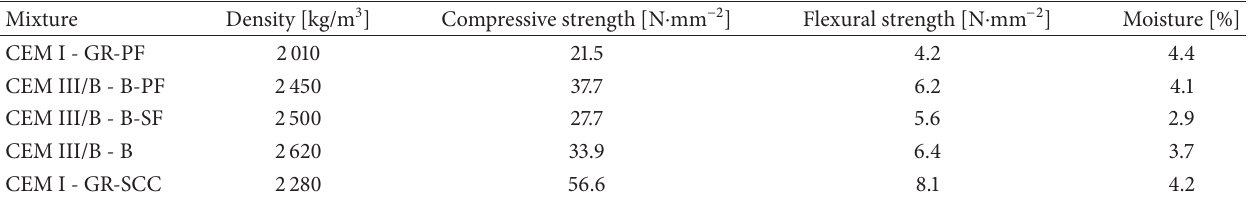
Table 3: Physical-mechanical properties of samples before heating.